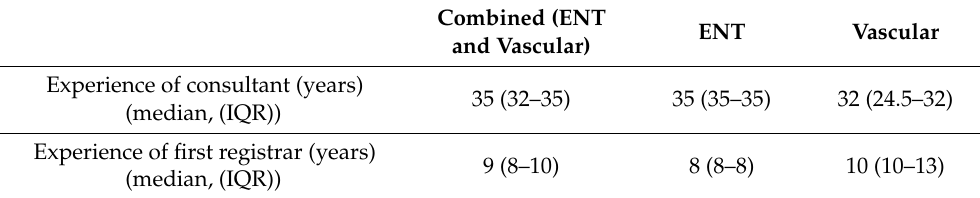
Table 1. Demographic data for surgical teams.